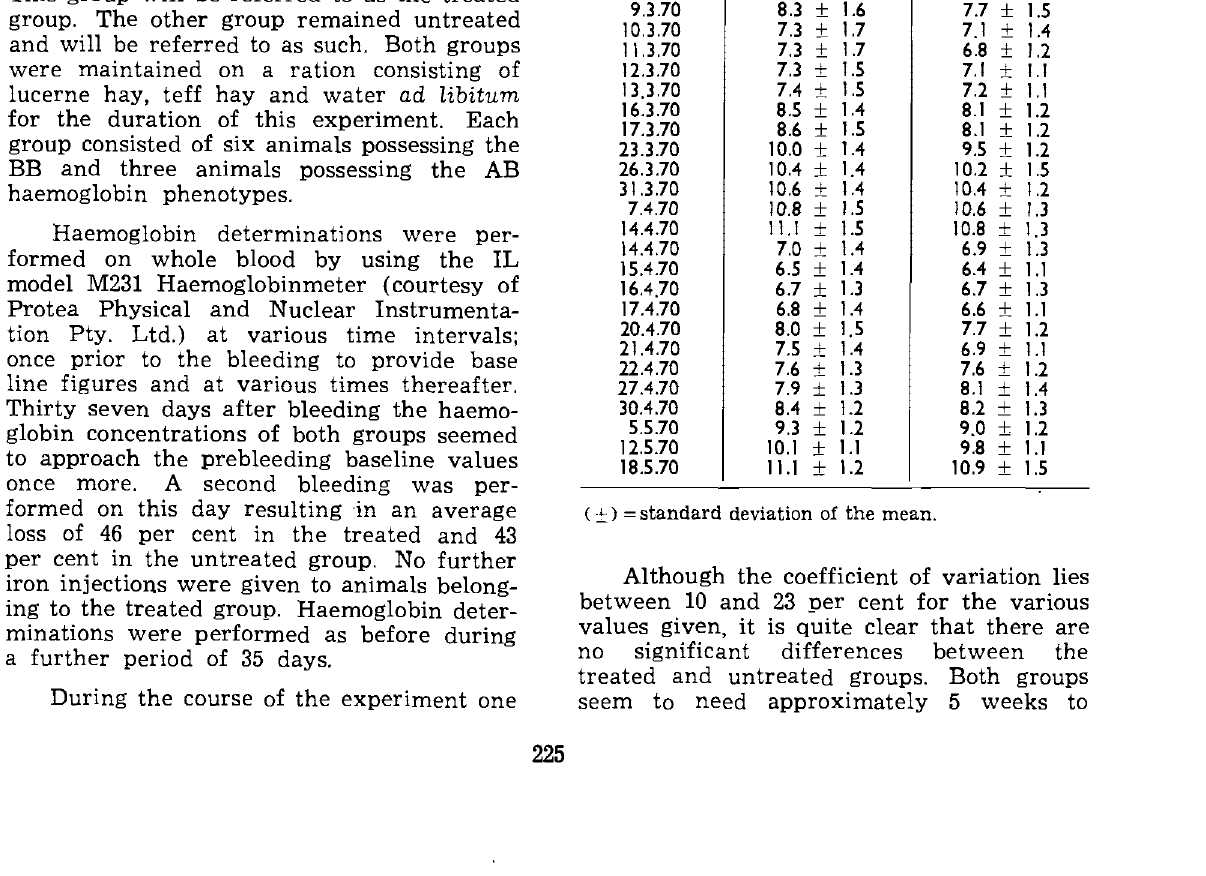
Table 1: HAEMOGLOBIN VALUES OF UNTREATED AND TREATED